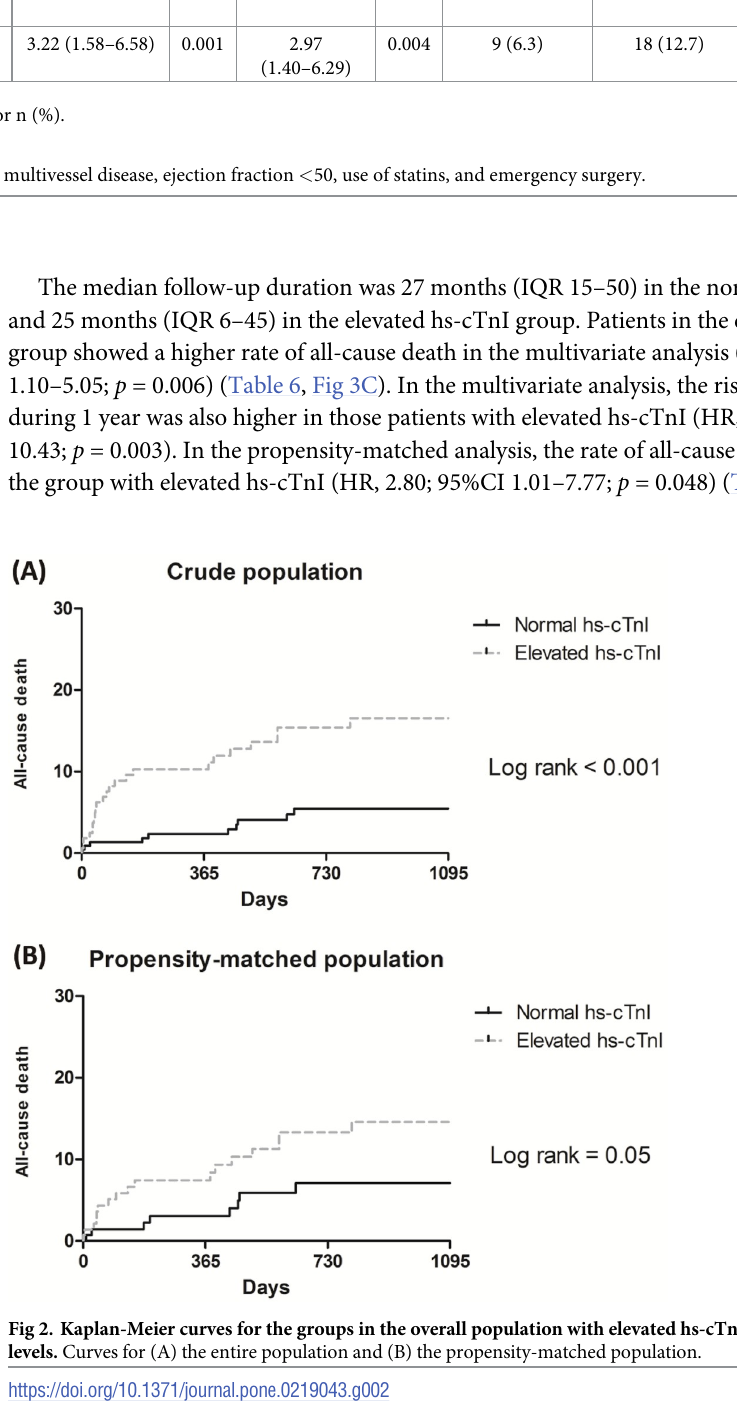
PLOS ONE | https://doi.org/10.1371/journal.pone.0219043 June 27,